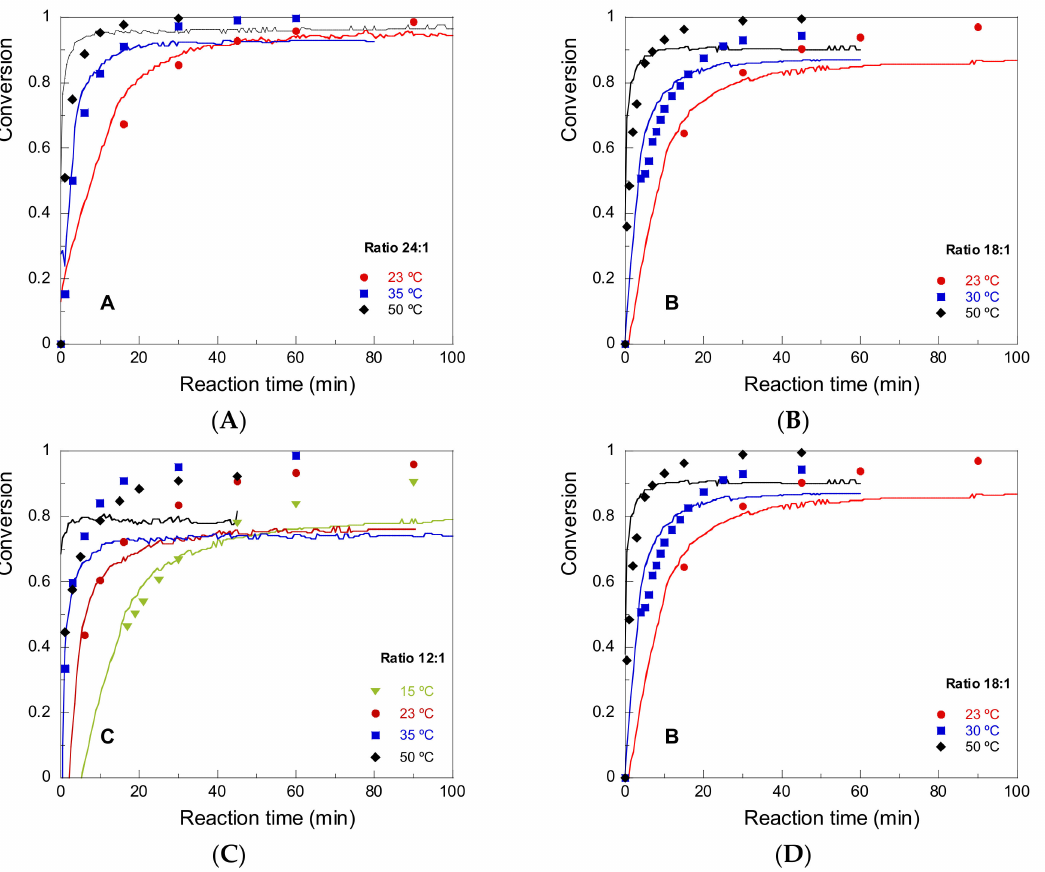
Figure 4. Evolution of oil conversion estimated through speed of sound propagation (lines) and offline SEC analyses (symbols) of a series of ethanolysis reactions with a 0.10 wt.% catalyst. ( A ) with 24:1; 4. ( B ) with 18:1, 4. ( C ) with 12:1 and ( D ) with 6:1 ethanol/oil molar ratio; all of them working at different temperatures (15 ◦ C in green, 23 ◦ C in red, 35 ◦ C in blue and 50 ◦ C in